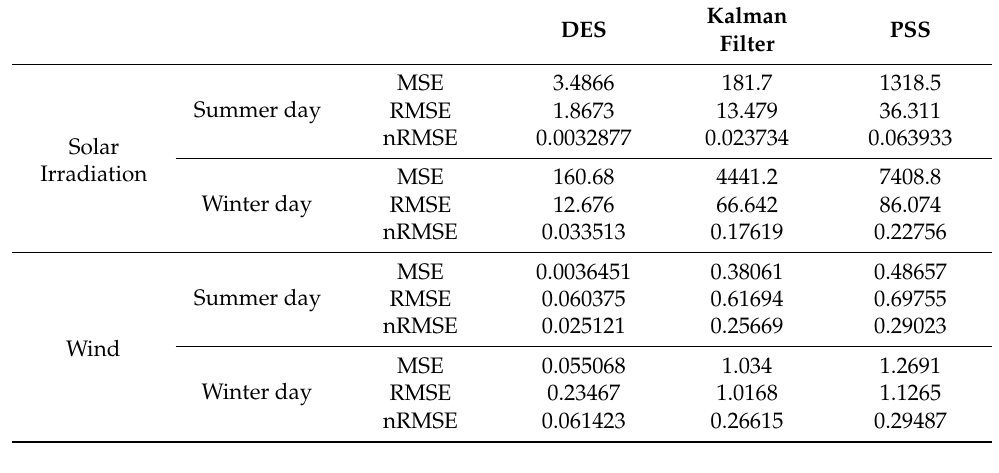
Table 1. Performance and comparison for statistics metrics.